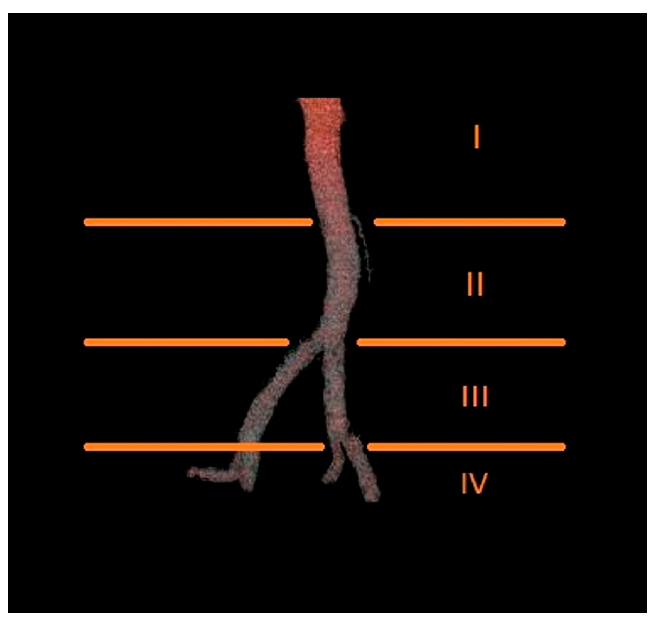
Figure 3. Diagram presenting the proposed levels of origin of renal arteries.